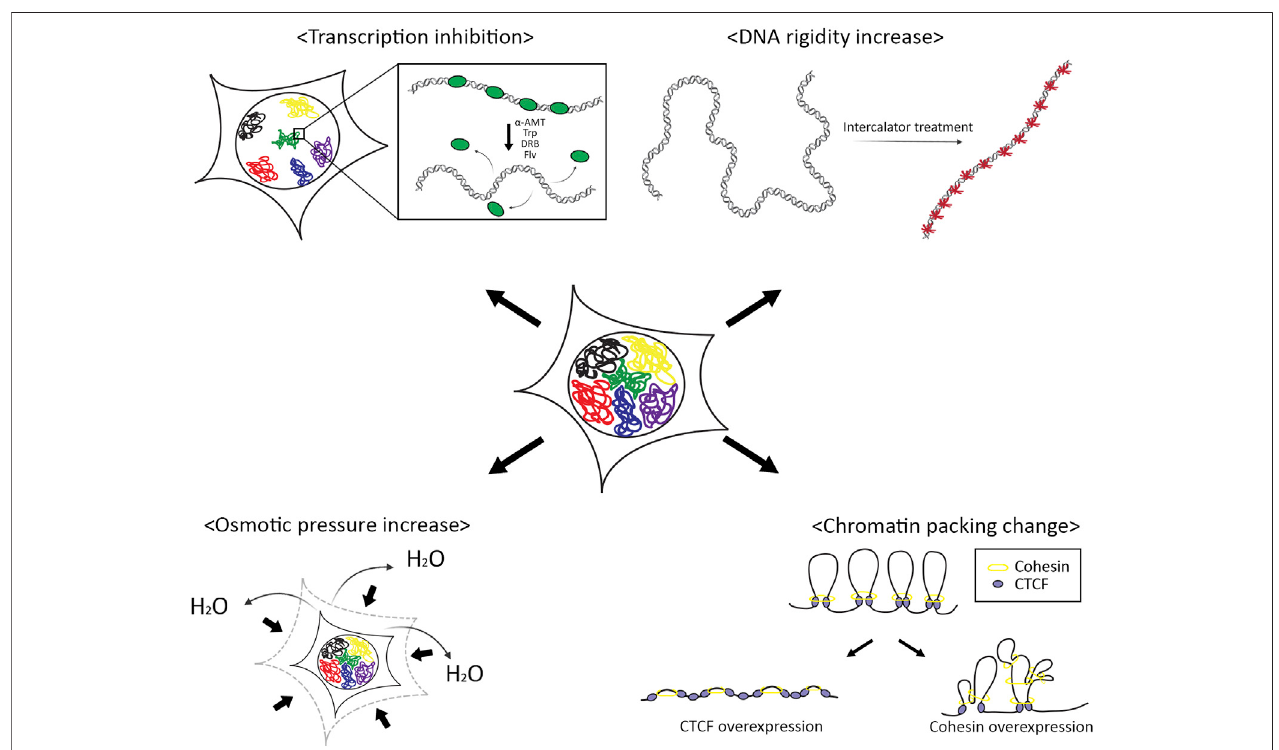
FIGURE 6 | Schematic summary of effects of physical perturbations on chromosomes. The movement of a chromosome is affected by the physical properties of chromatin fi bers,rigidity,andvolumecon fi nement.TranscriptionfactorsassociatedwithchromatinandDNAintercalatorsmakechromatinmorerigid.Osmoticpressure and chromatin compaction by chromatin architectural proteins reduce effective nuclear space for chromosome movements.